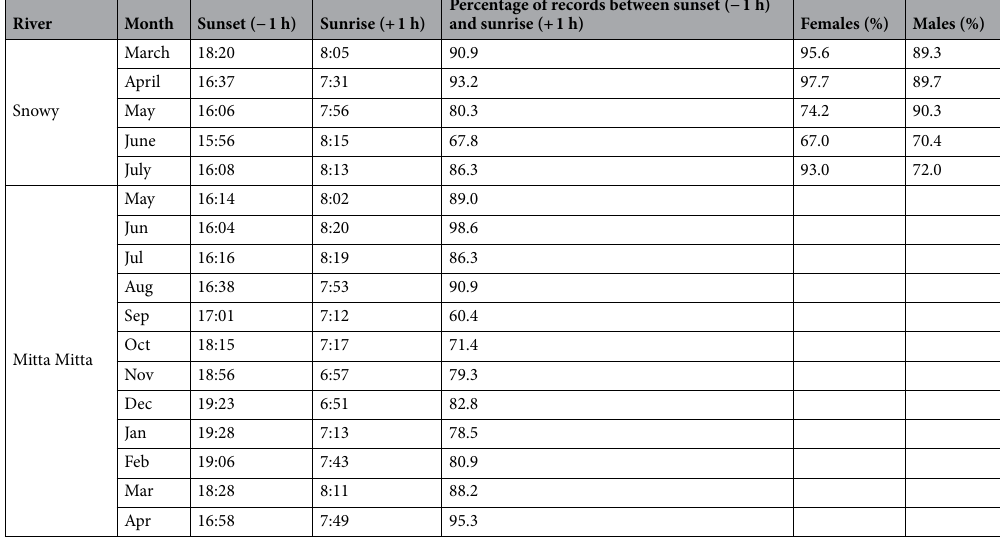
Table 2. Average times one hour before and after sunset and percentage of nocturnal platypus records (between one hour before sunset and one hour after sunrise) on the Snowy River (March–July 2017) and Mitta Mitta River (May 2018–April